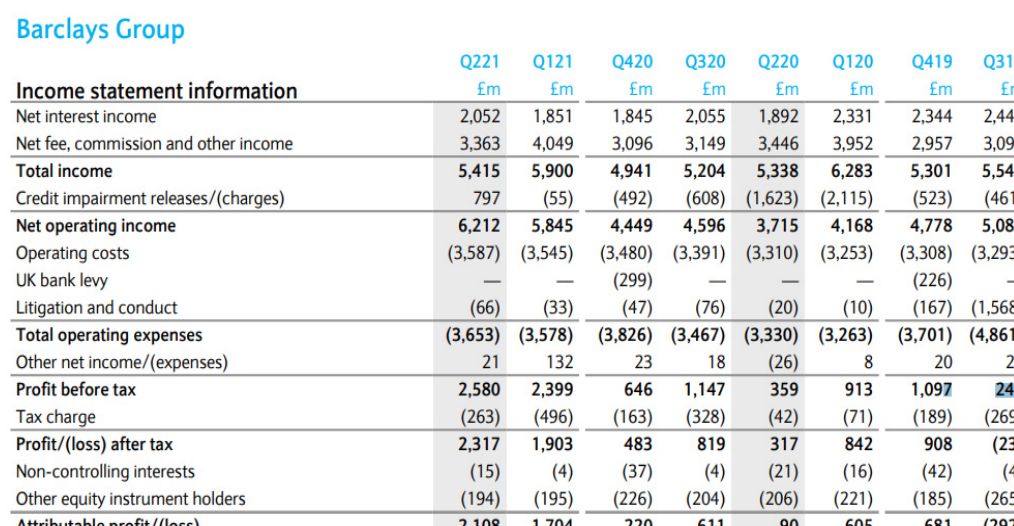
Figure 1. Barclays Group 2nd quarter income statement information at 30 June 2021 [3]. Data source: Barclays Group Quarterly result summary of 2nd quarter Financial report at 30 June 2021.